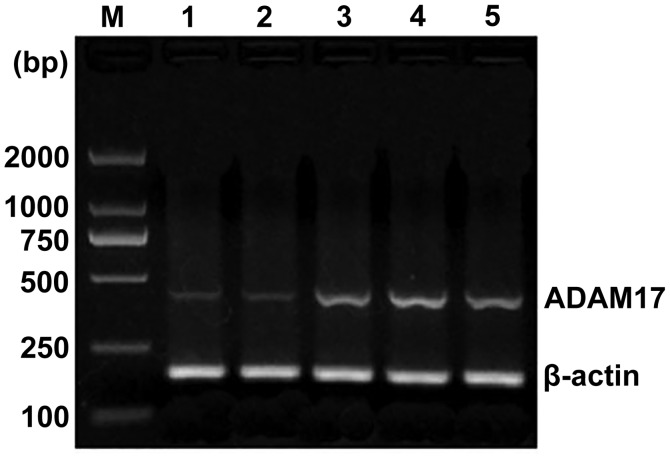
A disintegrin and metalloproteinase 17 mRNA reverse transcription polymerase chain reaction amplification results. Lanes: M, DNA marker; 1 and 2, normal esophageal mucosa; 3–5, esophageal squamous cell carcinoma.